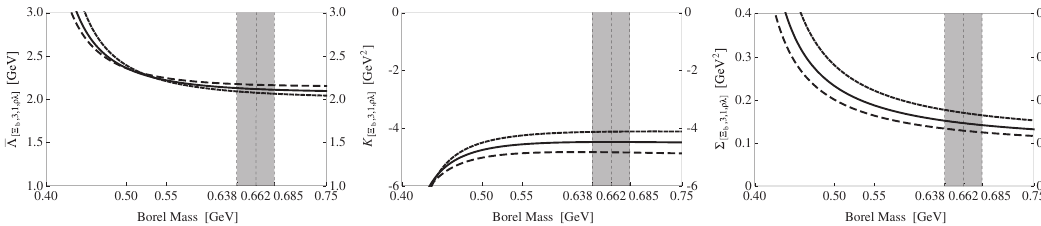
Figure 3. Variations of Λ Ξ ( left ), K Ξ ( middle ), and Σ Ξ ( right ) as functions of the b ,3,1, ρλ b ,3,1, ρλ b ,3,1, ρλ Borel mass T , where the short-dashed, solid, and long-dashed curves are obtained by fixing ω c = 4.4, 4.6, and 4.8 GeV, respectively. These figures are plotted for the bottom baryon doublet [ Ξ b ( ¯3 F ) ,3,1, ρλ ] .